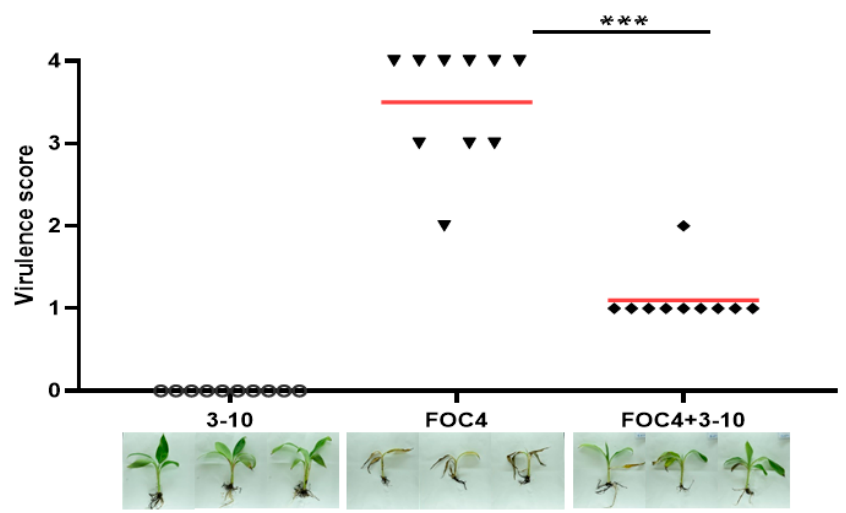
Figure 5. Biocontrol efficacy of strain 3-10 against banana wilt caused by Fusarium oxysporum f. sp. cubensis FOC4. Strain 3-10 was cultured in LB medium overnight and resuspended with ddH 2 O to a final concentration of OD 600 = 0.1. FOC4 strain was cultured on PDA plates for about 5 days and washed with ddH 2 O to collect hypha and conidia. Half roots of each banana seedling (30 seedlings) were randomly cut off, 20 seedlings were soaked in pure FOC4 suspension and 10 were soaked in ddH 2 O for 20 minutes, and re-planted in sterilized pots. Then 100 mL of 3-10 cell suspension and ddH 2 O was respectively drenched into soils of each 10 FOC4-soaked seedlings, while 100 mL of ddH 2 O was also drenched into the soils of the ddH 2 O-soaked seedlings. Symptoms were observed every day and pictures were taken in the 16 th day after inoculation. Data were subjected to unpaired two-tailed t-test analysis by Graphpad Prism 8.4.1 (*** p < 0.001). The marks in the plot area represent the virulence scores of the inoculated seedlings, and the red lines represent the average virulence scores.